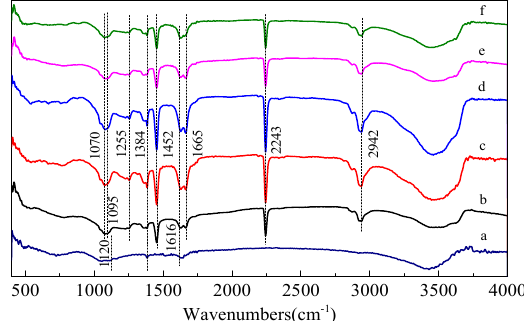
Figure 5. Fourier-transform infrared (FTIR) spectra of ( a ) SWCNTs; ( b ) PAN nanofiber; and corresponding composite nanofibers with the different SWCNT concentrations of ( c ) 0.5 wt %; ( d ) 1 wt %; ( e ) 1.5 wt %; ( f ) 2 wt %.